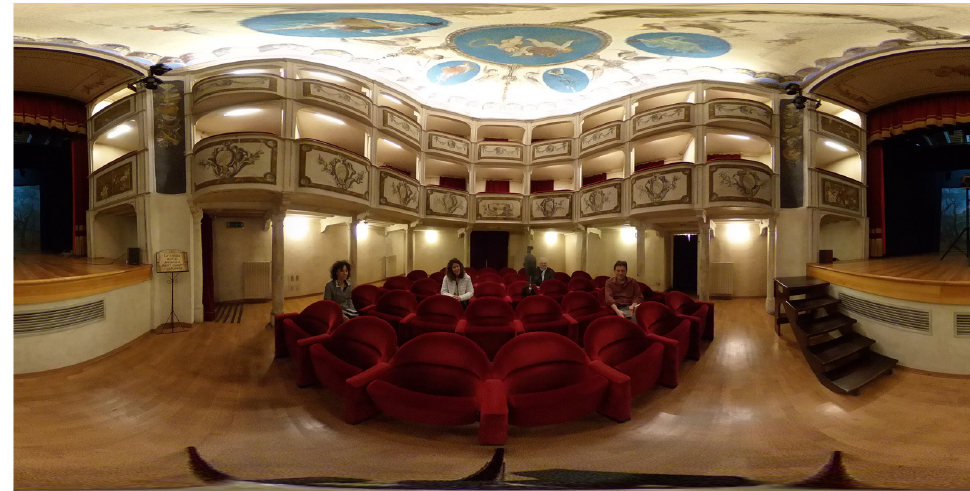
Figure 6. A 360 picture of the measurements in the Monte Castello di Vibio theatre with the equipment.